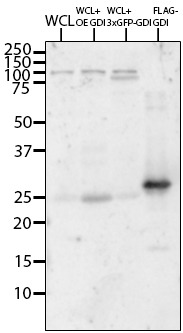
X. laevis RhoGDI antibody specificity.Western blot stained with αGDI antibody to determine specificity; lane 1: X. laevis oocyte whole cell lysate (WCL), lane 2: WCL of oocytes overexpressing GDI, lane 3: WCL of oocytes expressing 3xGFP-GDI, lane 4: purified FLAG-GDI.